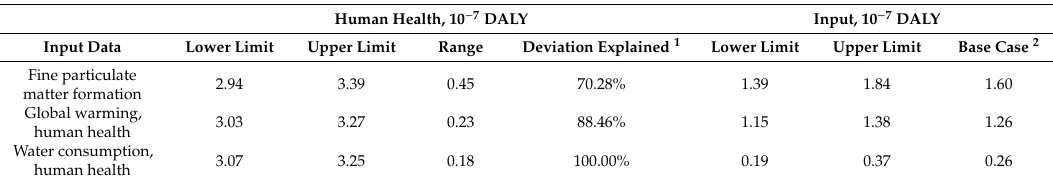
Table 6. Results of the Monte Carlo (MC) simulation performed in Crystal Ball (CB) for the tornado-type sensitivity analysis of the significant categories of impact on human